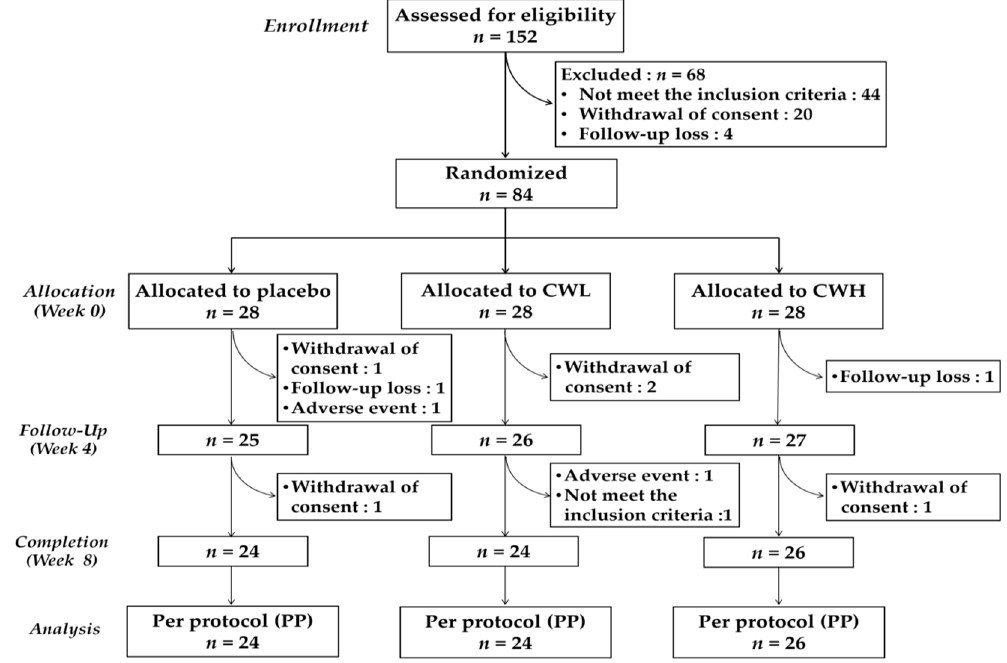
Figure 1. Consolidated Standards of Reporting Trials diagram for flow of participants enrolled in the clinical trial analyzing the cholesterol-controlling e ff ect of Cynanchum wilfordii ; CWL, low-dose treatment group (300 mg/day); CWH, high-dose treatment group (600 mg/day).